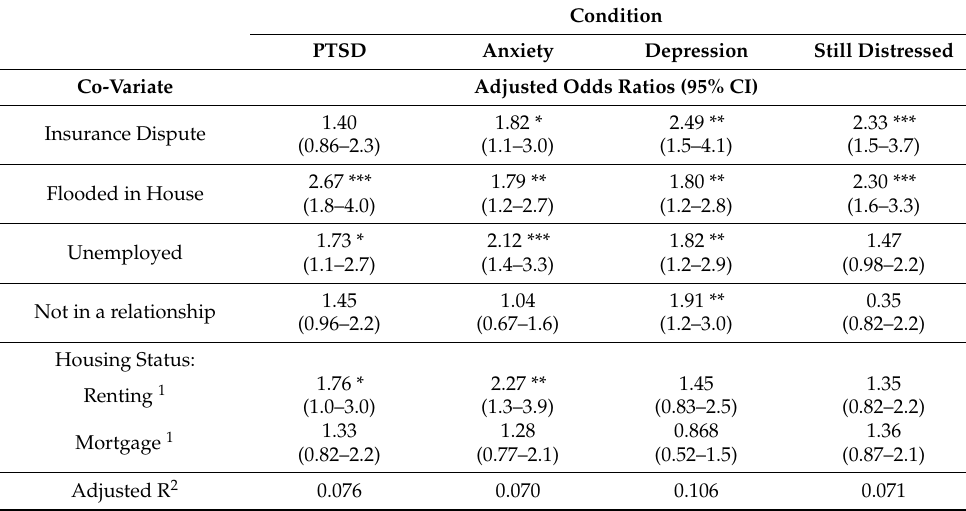
Table 3. Adjusted regression